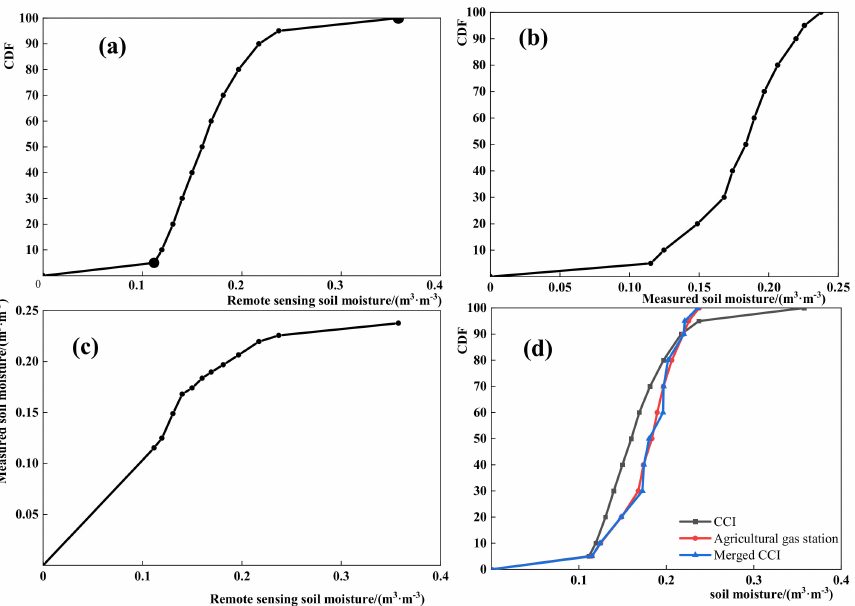
Figure 3. CDF curve for the ( a ) measured soil moisture; ( b ) satellite soil moisture; ( c ) piecewise linear regression; and ( d ) comparison before and after CDF